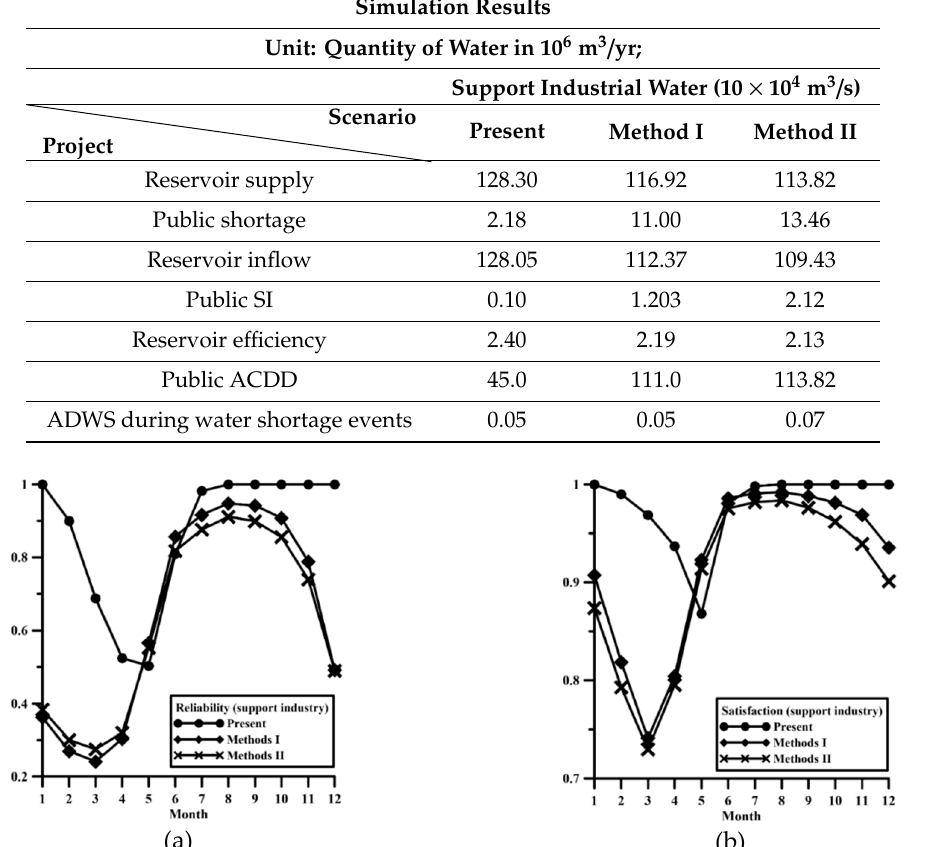
Table 8. Comparison of historical and synthesis flow data